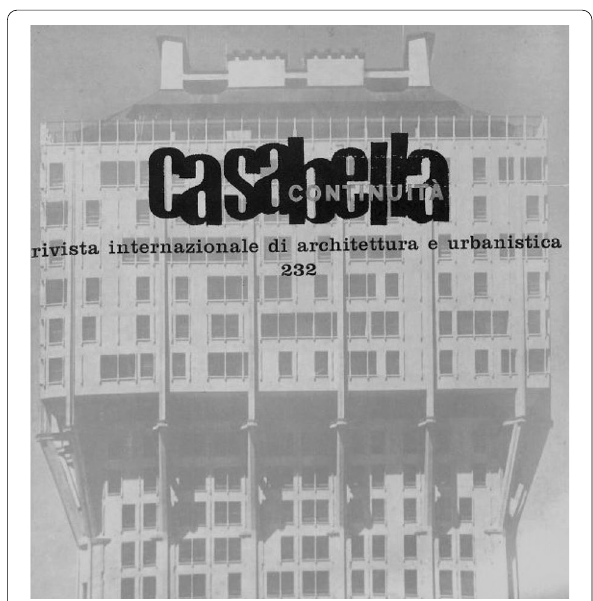
Fig. 9 BBPR’s Torre Velasca featured on the cover of the issue 232 of Casabella Continuità published in October